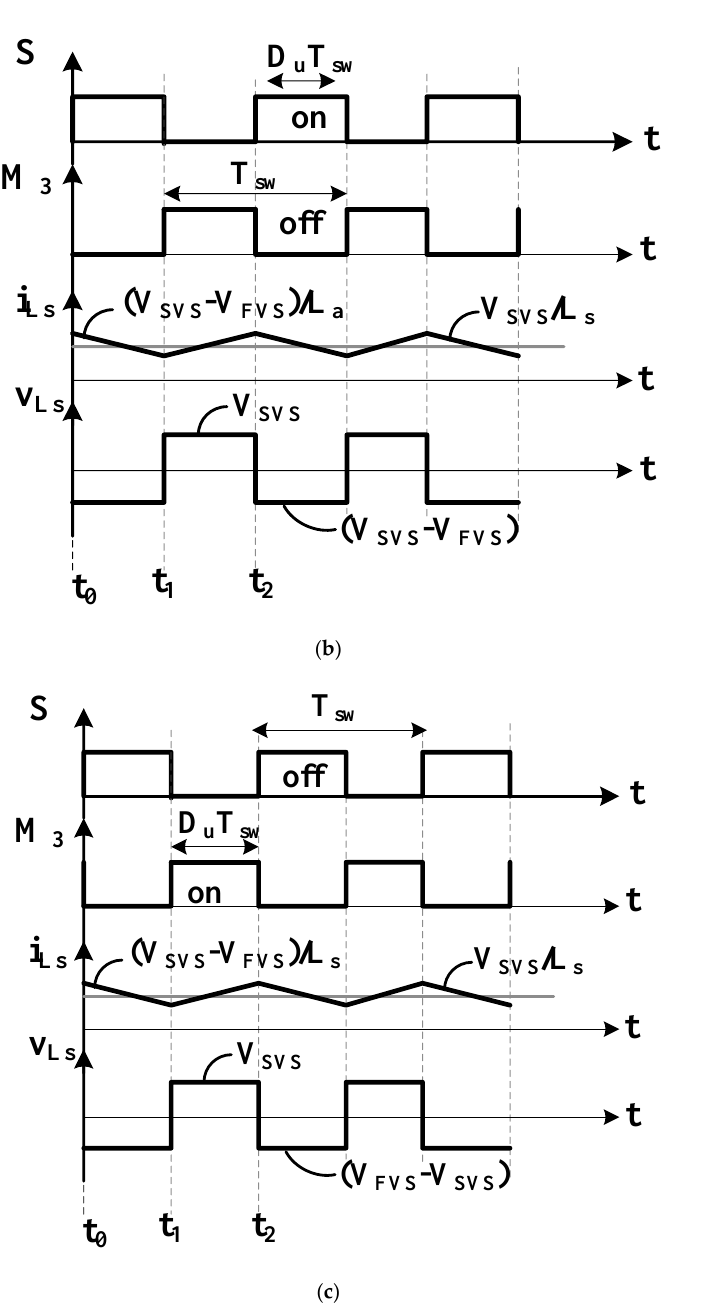
Figure 7. BDC’s dual low-voltage sources buck/boost mode. ( a ) Schematic Diagram. ( b ) Buck-mode stable-state waveforms. ( c ) Boost-mode stable-state waveforms. a buck converter. It is because power flows from first voltage source to second voltage source. This depicts the circuit stages in buck mode of the planned BDC with dual low-